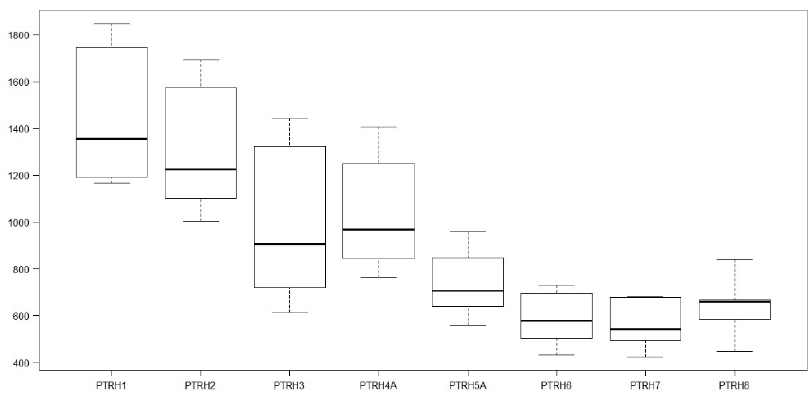
Figure 4. Boxplots: Average annual precipitation by river basin district (mm).